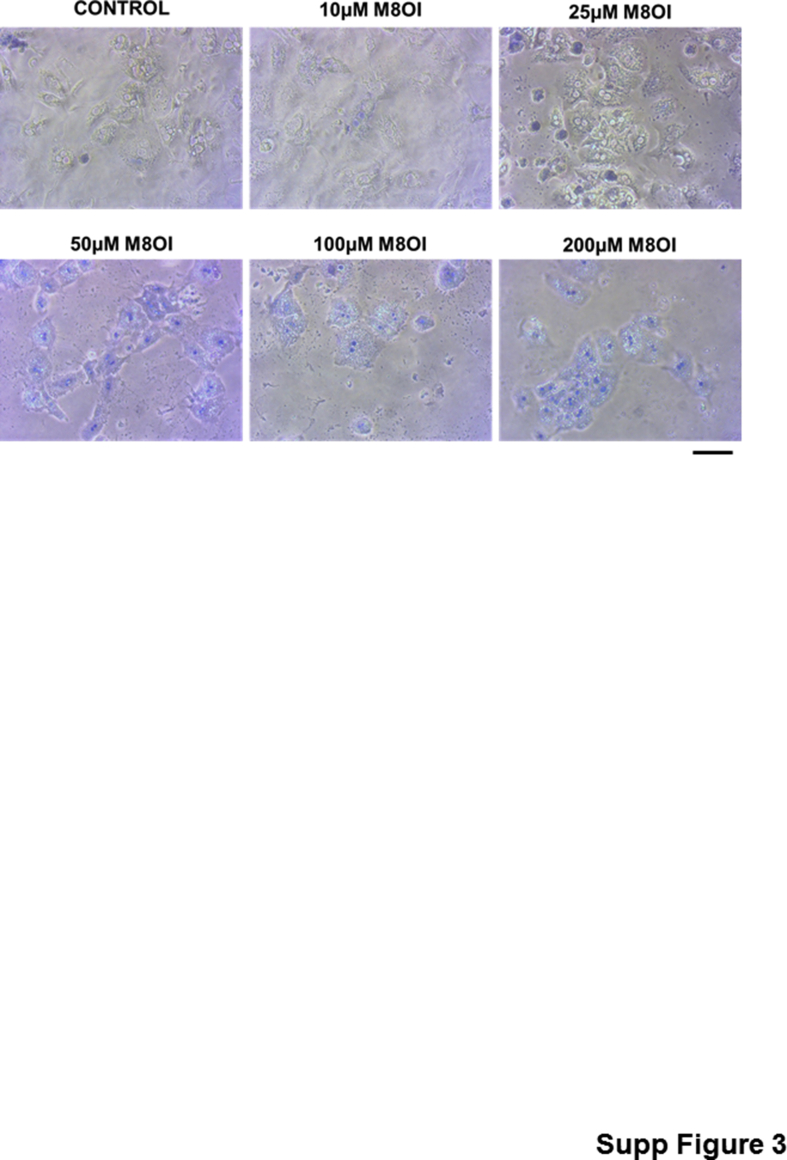
Trypan blue staining of hepatocytes exposed to M8OI. Typical phase contrast images of hepatocytes exposed to trypan blue after treatment with the indicated chemicals for 24 h. Bar = 100 μm. .